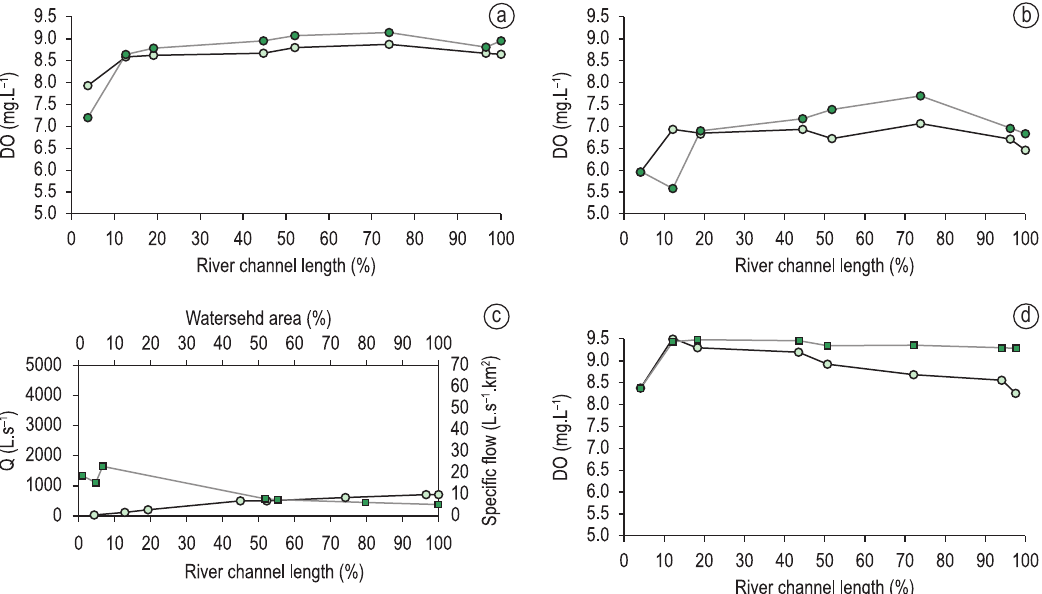
Figure 5. Concentrations of dissolved oxygen (mg.L -1 ) in Canha River, during the spring (a - September), summer (b - January), autumn (c - April) and winter (d - July) periods, respectively. ● : observed dissolved oxygen; “ ■ ”: simulated dissolved oxygen.